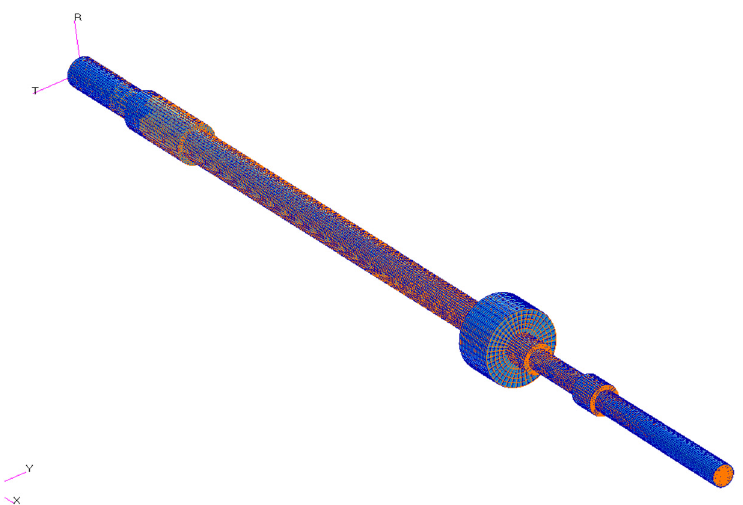
Figure 15. Shaft deformation.